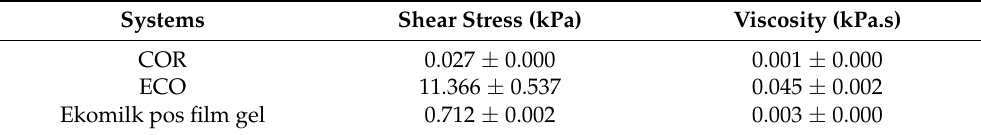
Table 1. Absolute rheological data of the systems. Systems